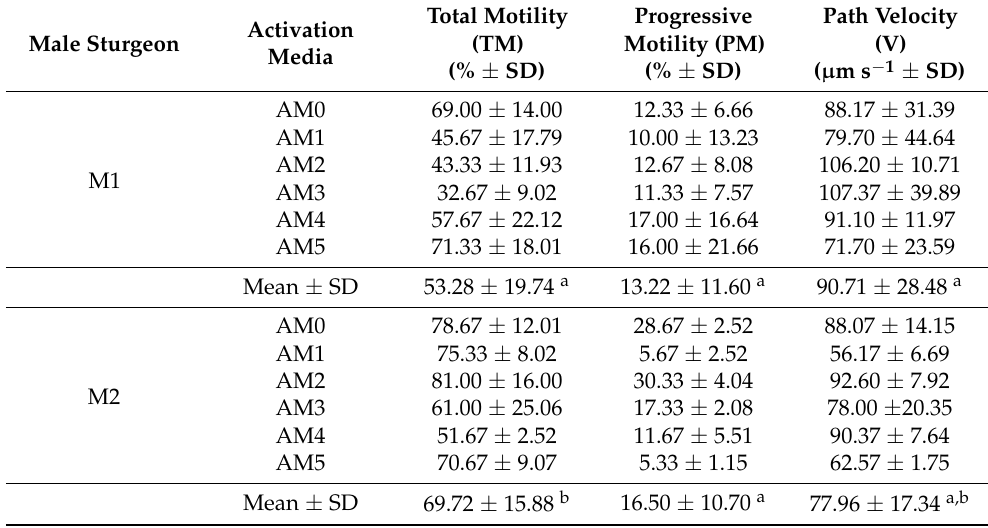
0.05). ≤ Table 4. The motility parameters according to the different semen activation media at different males. Different letters of the mean ± SD on table columns indicate significant differences ( p ≤ 0.05).